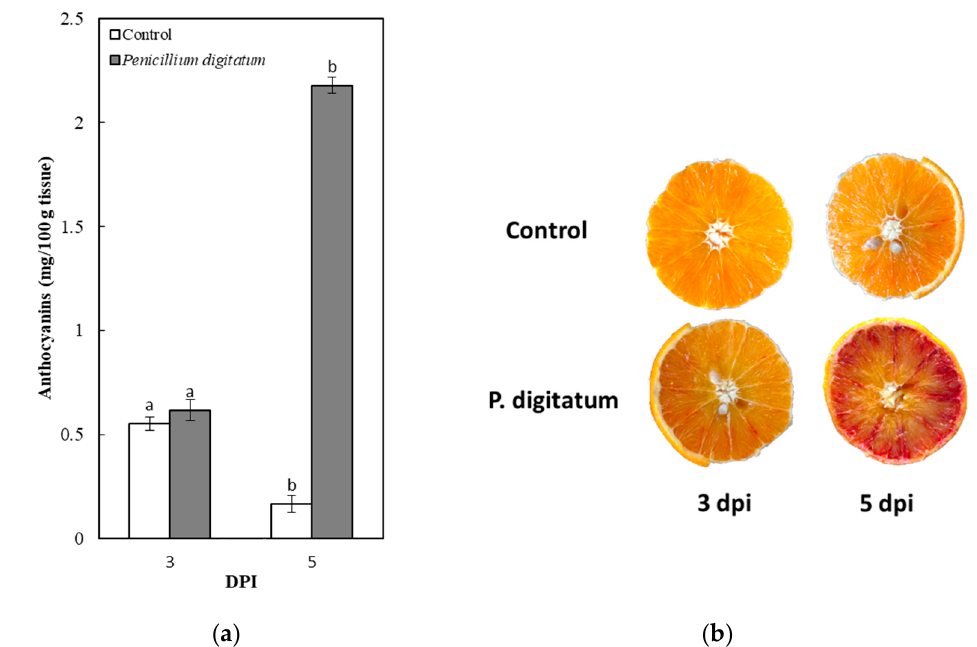
Figure 2. ( a ) Anthocyanin content in control and inoculated fruits; ( b ) Picture of sweet orange control and inoculated fruits. Each bar represents the mean value of three replications ± SD. Significantly different values, within each sampling time, are indicated by different letters ( p < 0.05).